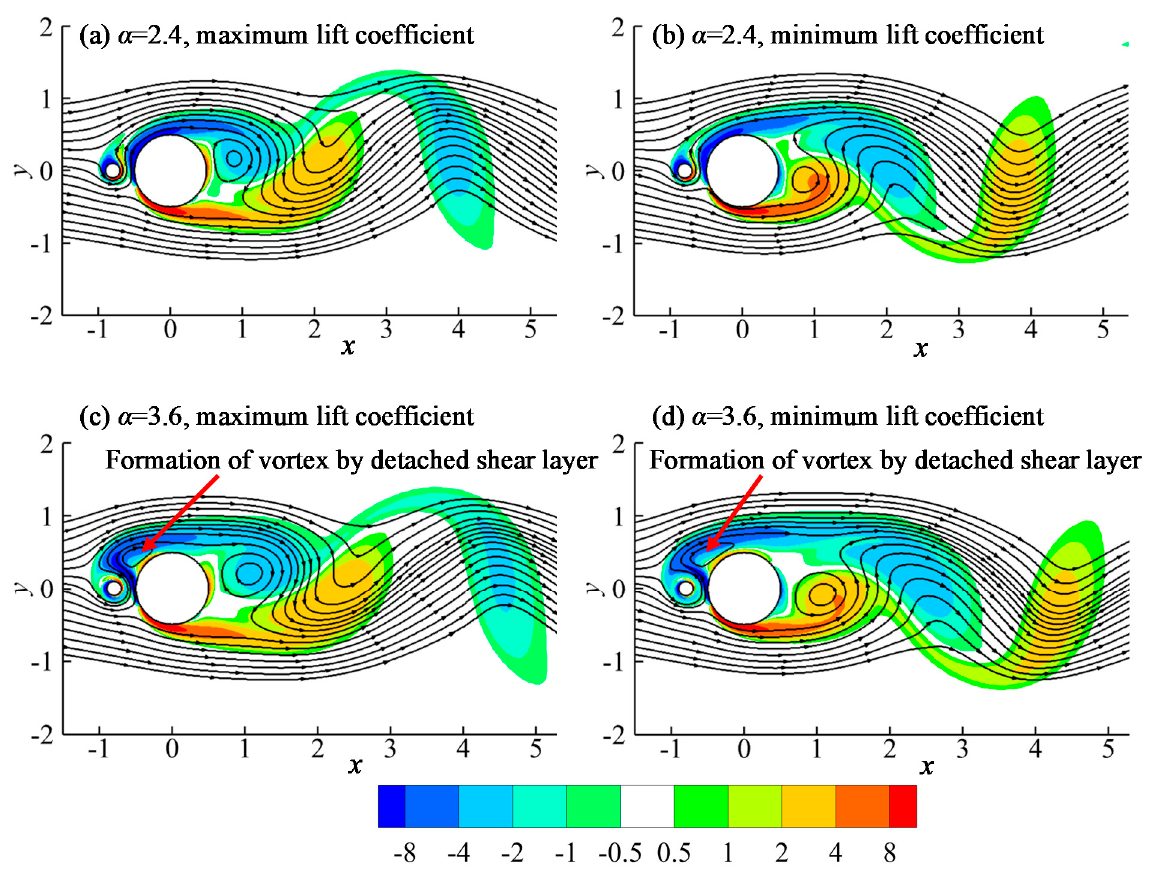
Figure 4. Streamlines and the contours of the nondimensional vorticity of instantaneous flows when the lift coefficient reaches its maximum and minimum values for β = 180°.